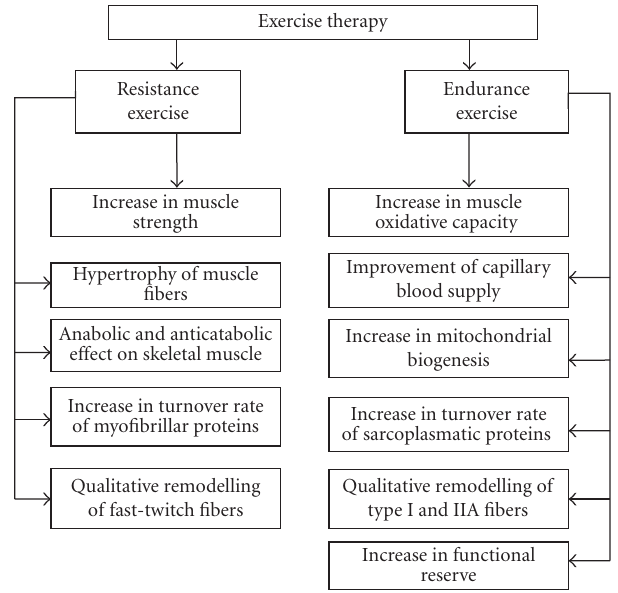
Figure 2: E ff ect of exercise therapy on aging, unloading, and glucocorticoid caused myopathic skeletal